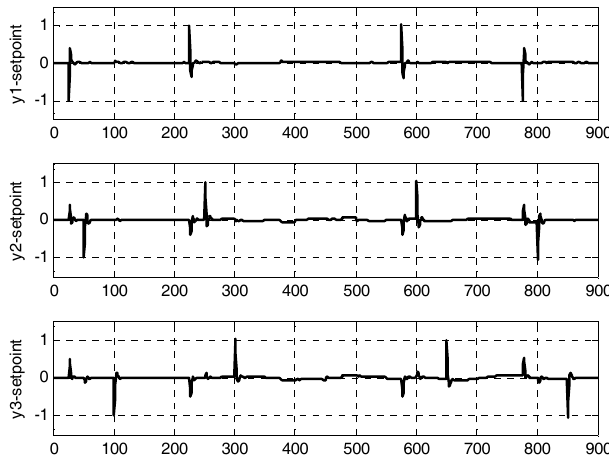
Figure 11. Control error of offset free MPC in dynamic PLS.